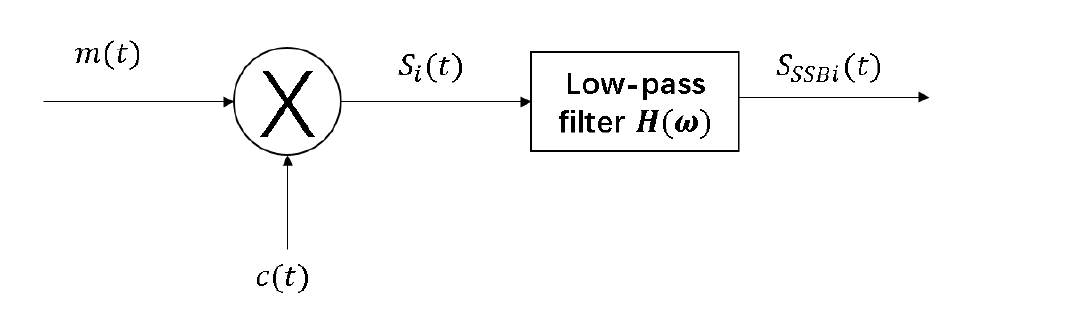
Figure 2. Range finding signal modulation block